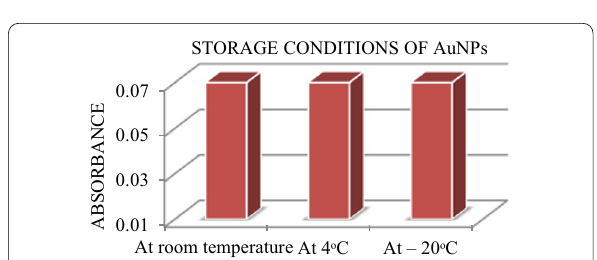
Fig. 11 Representation graph of storage conditions of